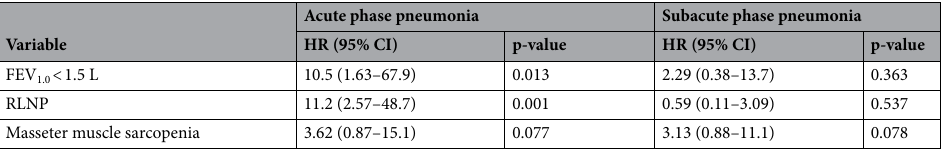
Table 3 summarizes the univariate and multivariate analyses of the association between the clinicopathological characteristics and OS in patients with esophageal cancer. In univariate analysis, the OS rate was significantly worse in patients with stage ≥ II (p < 0.001), acute phase pneumonia (p = 0.042), and masseter muscle sarcope- nia (p < 0.001). In multivariate analysis, stage ≥ II (hazards ratio [HR]: 3.82; 95%CI 1.66–8.81; p = 0.002), and